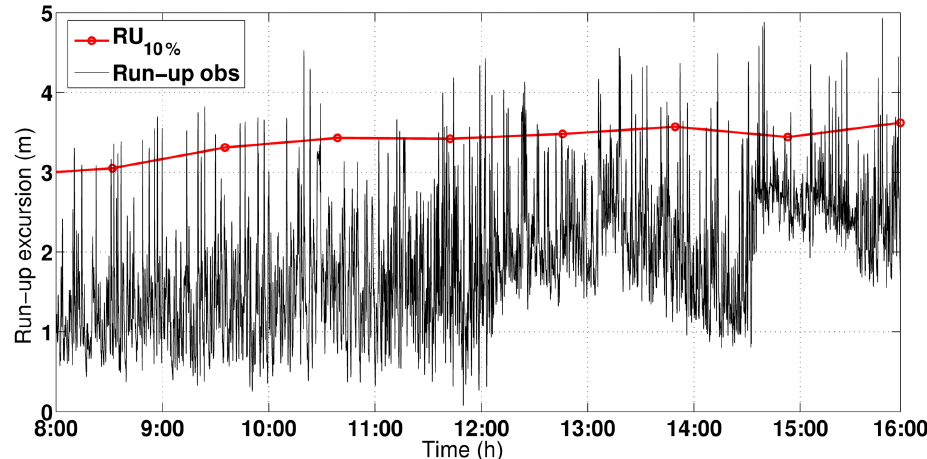
Figure 11. Wave run-up levels collected (black line) using pixel timestacks derived from video camera data at Bonassola on 10 February 2016 from 08:00 to 16:00UTC; Ru 10% trend (red line) as obtained by the timestack analysis at 1h intervals during the investigated time